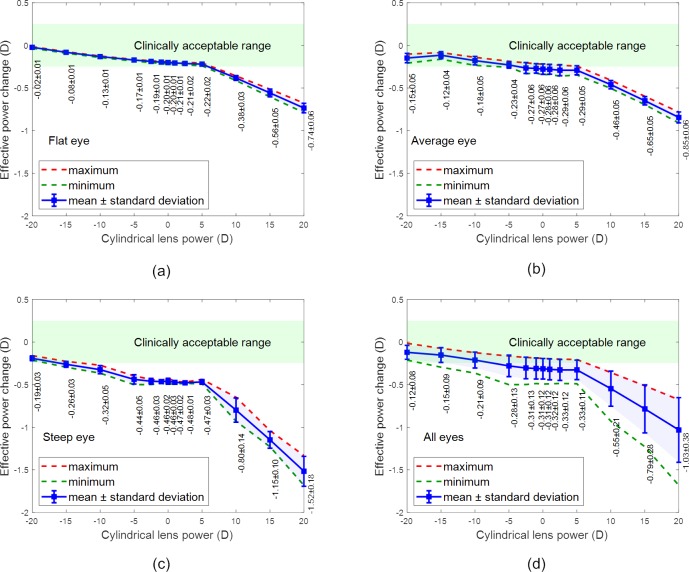
Effective power change in toric lenses where the x-axis reports the cylindrical power of the contact lens when fitted to (a) a flat eye, (b) an average eye, (c) a steep eye and (d) all eyes.